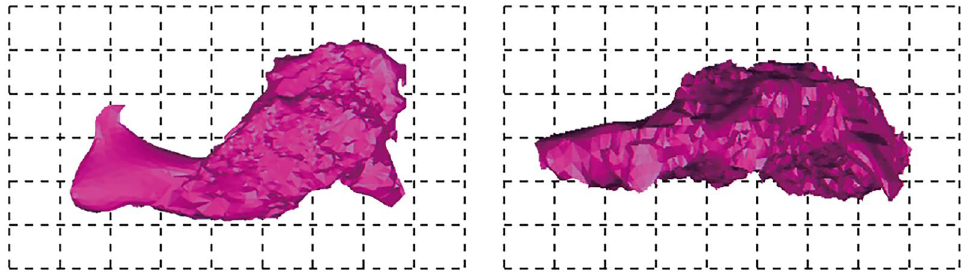
Figure 17. 3D model of mined-out area of drilling hole 1320-181, 1320-182 and 1320-183. the geometric shape of mined-out areas can be fully ascertained by joint detection and mutual supplement of multiple holes, this goaf has a large span and the roof caving of goaf is